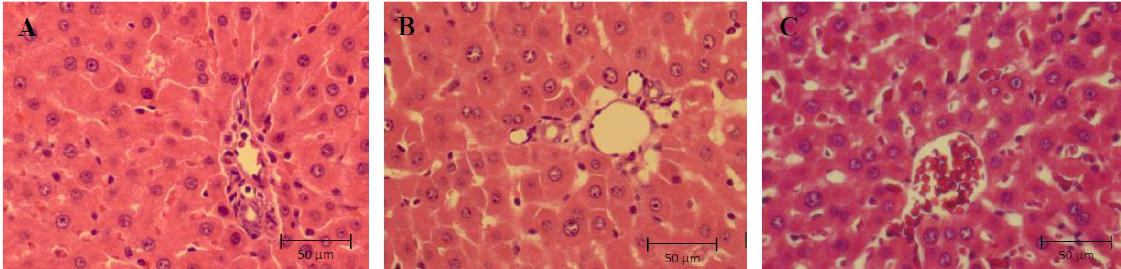
Figure 1 Microscopic photographs of the liver tissue in (A) N group (B) STZ group and (C) STZ +